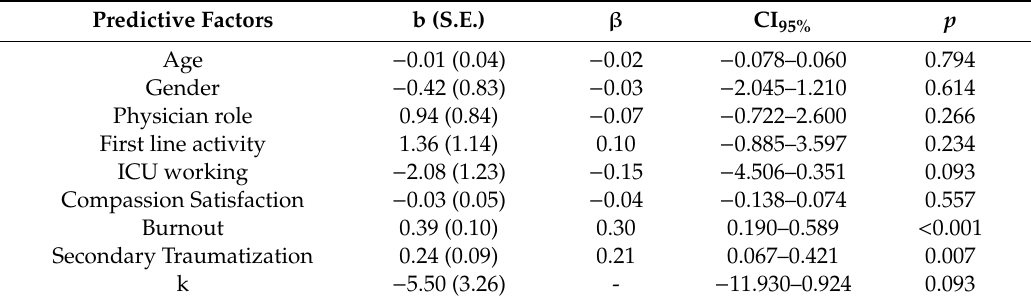
Table 2. Linear regression model: sociodemographic variables and ProQOL-5 subscales scores as predictive variables associated with PHQ-9 score in the total sample (N = 265).